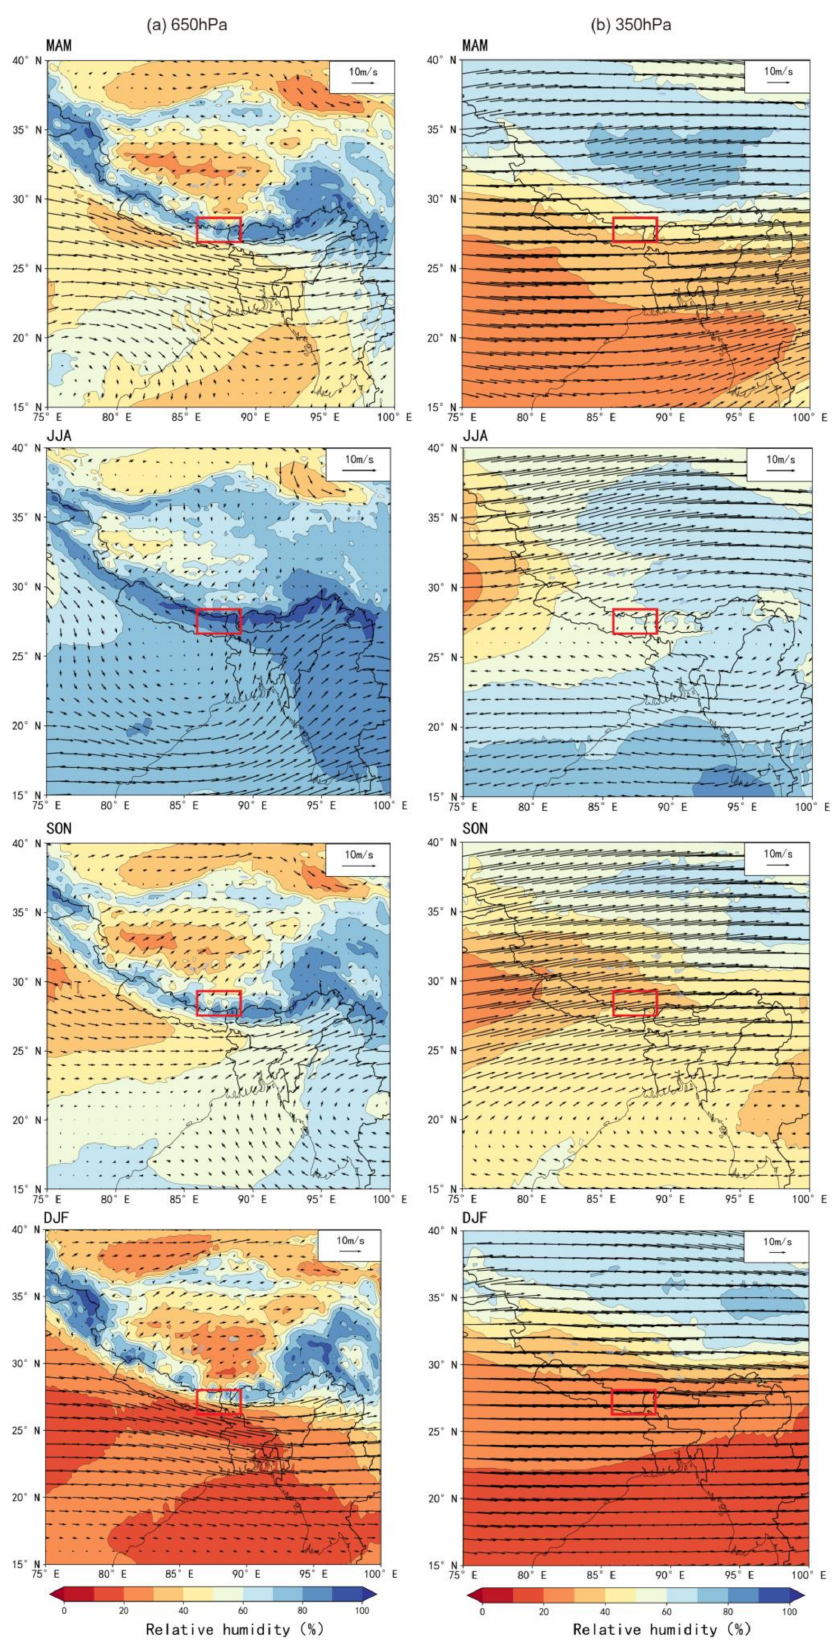
Figure 4. Seasonal spatial variation of relative humidity and wind vector (U, V) at different pressure levels from June 2019 to June